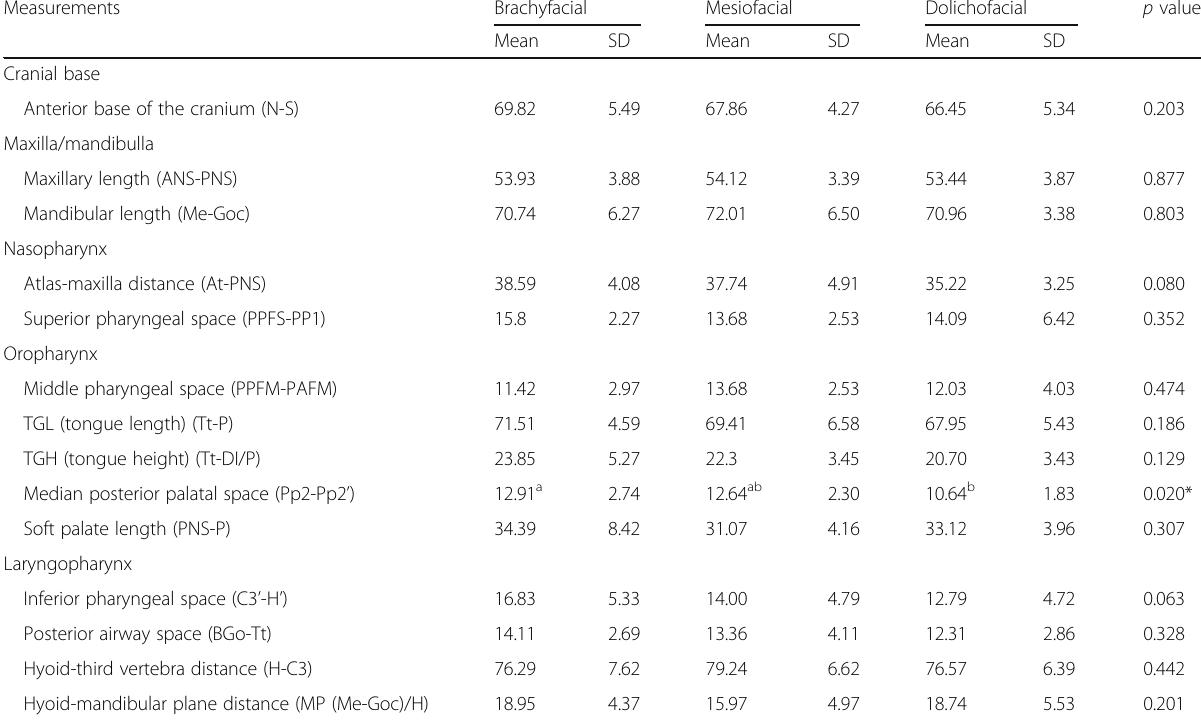
these factors cause oral dysfunction, such as lip incom- petence, low position of the tongue in the floor of the mouth, tongue thrust, and may lead to unbalanced muscle and function [32] disturbances in swallowing, mastication, speech [34], and stability of occlusion [35]. Table 1 Mean and standard deviation of the 14 factors of sleep apnea cephalometry and the respective p values of the comparison among the groups Measurements